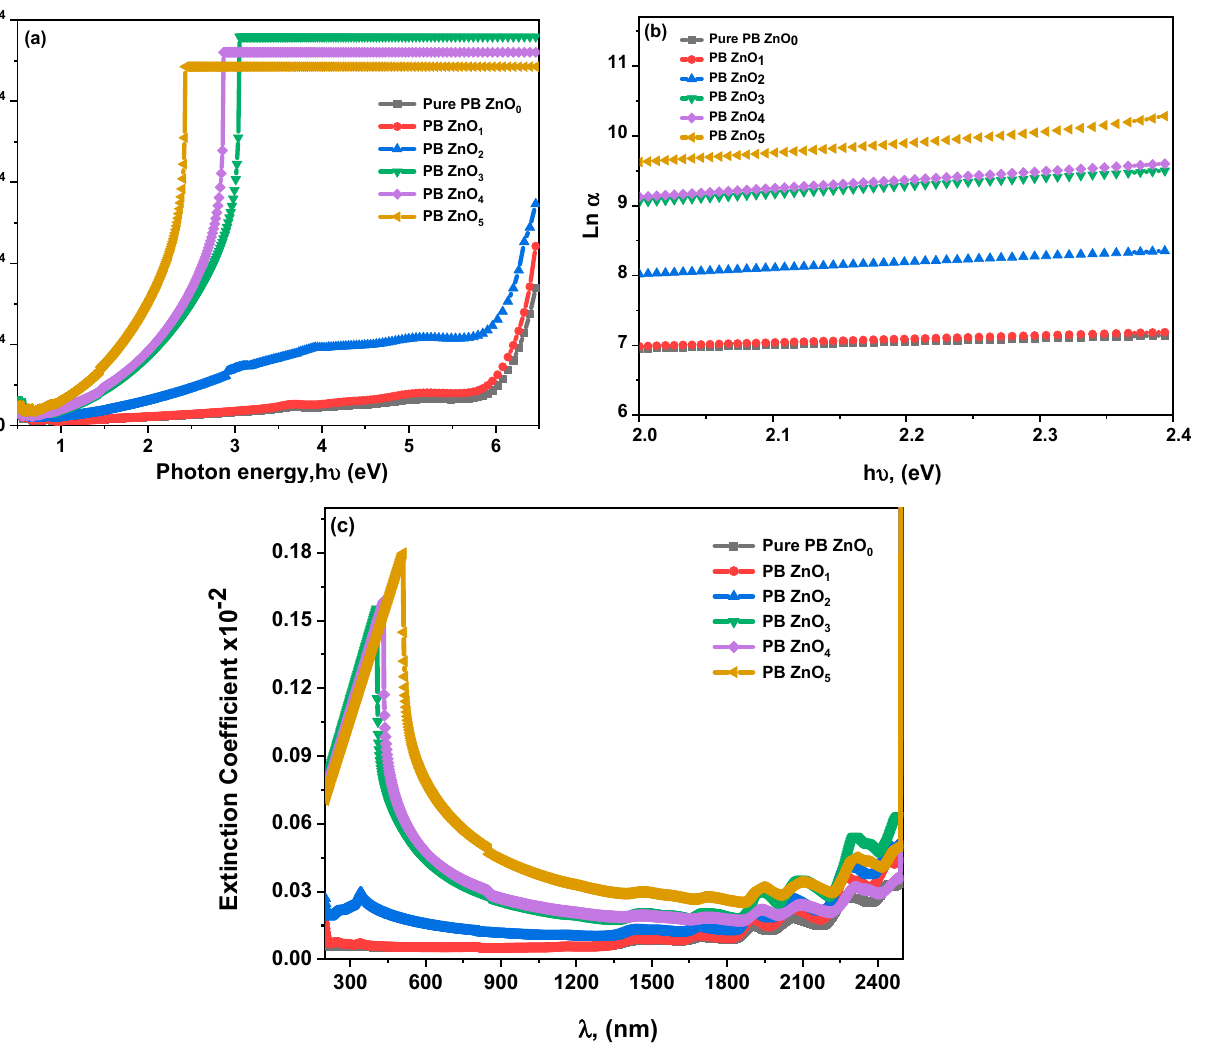
Figure 4. ( a – c ): ( a ) Optical absorption coefficient, ( b ) ln α versus h ν , and ( c ) Variation of extinction coefficient as a function of wavelength for the PVA/PVP blend and ZnO polymeric nanocomposite films. Table 2. Optical indirect/direct Bandgap of ZnO NPs-doped PVA/PVP polymeric nanocomposites. Samples